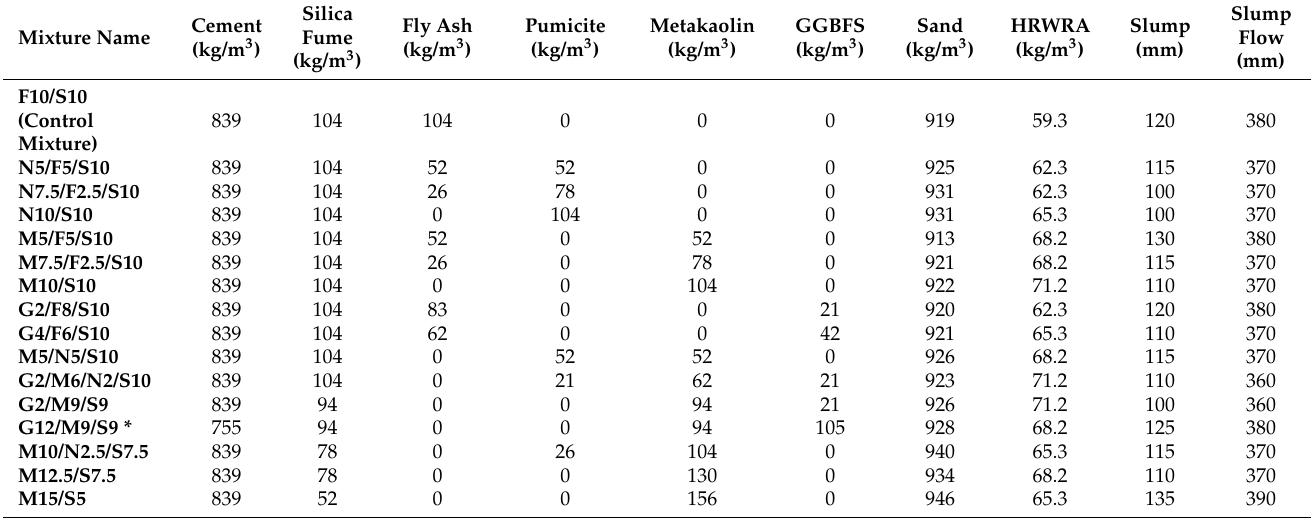
Table 2. Concrete mixture proportions and workability